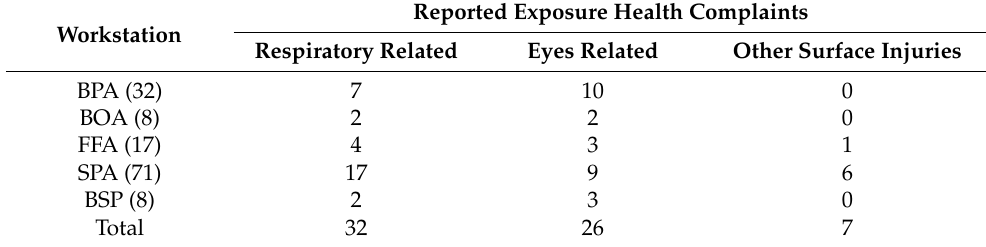
Table 2. Reported indoor air syndrome among employees of